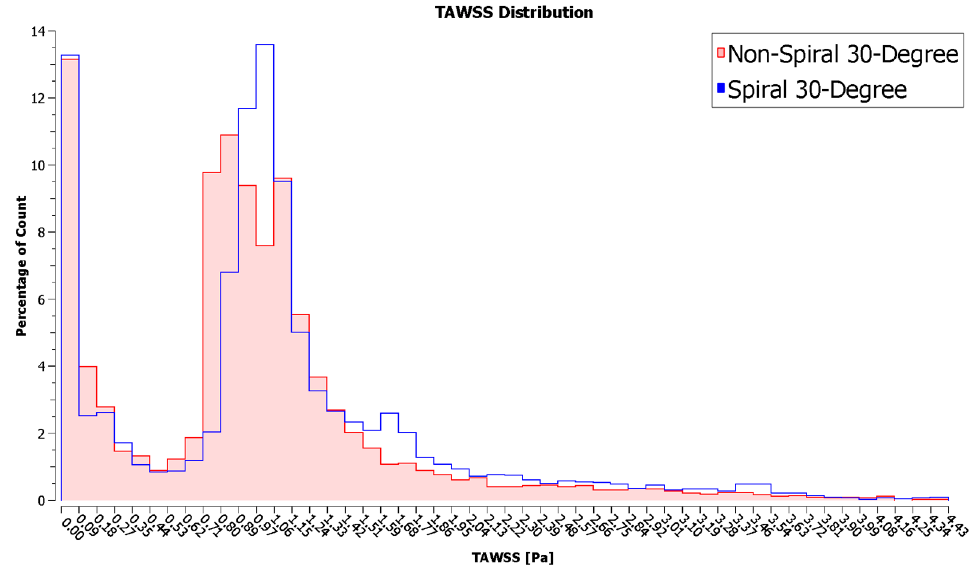
Figure 15. Frequency distribution of TAWSS values in the artery.